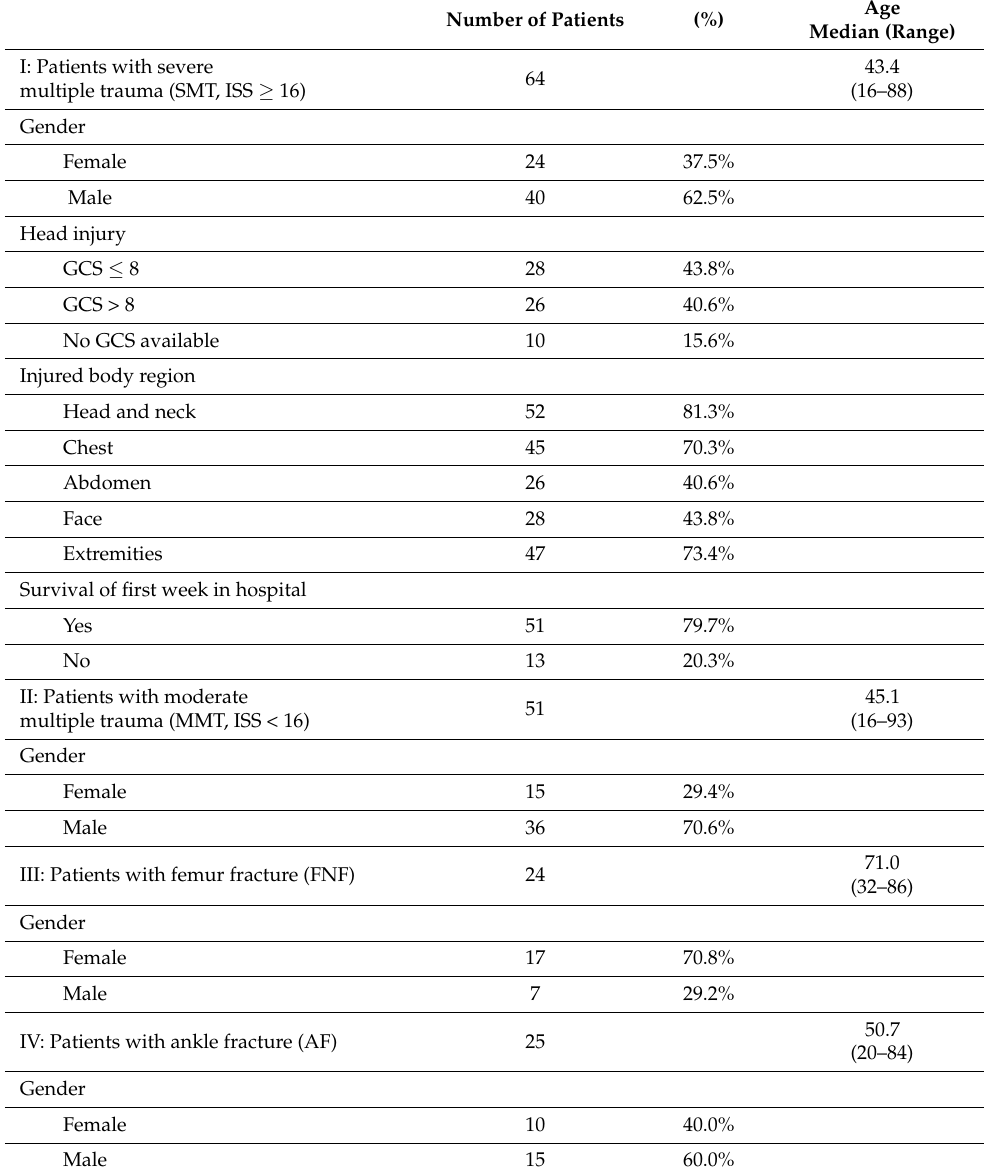
Table 1. Patient